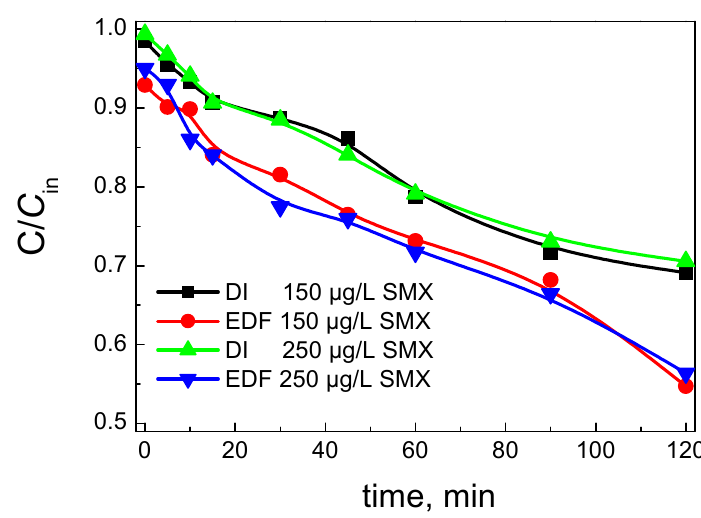
Figure 11. Degradation of sulfamethaxazole (SMX) using 1000 mg / L sodium persulfate (SPS) as oxidant and 100 mg / L catalyst with time. The concentration of SMX is presented.